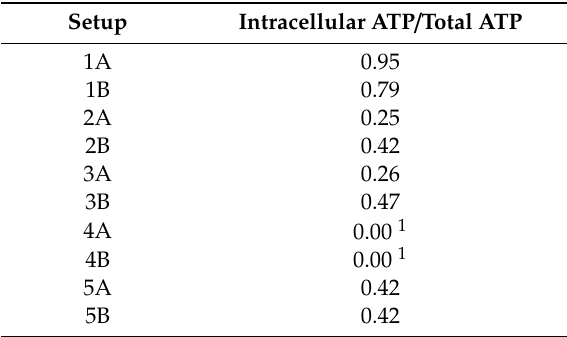
Table 3. Intracellular vs. Total-ATP concentration on the membrane surface. 1 Total and Free-ATP was very